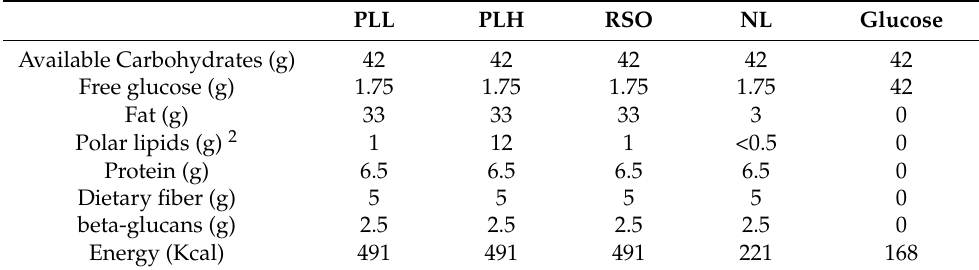
Table 1. Nutritional composition of the breakfast meals per serving (500 mL) 1 .